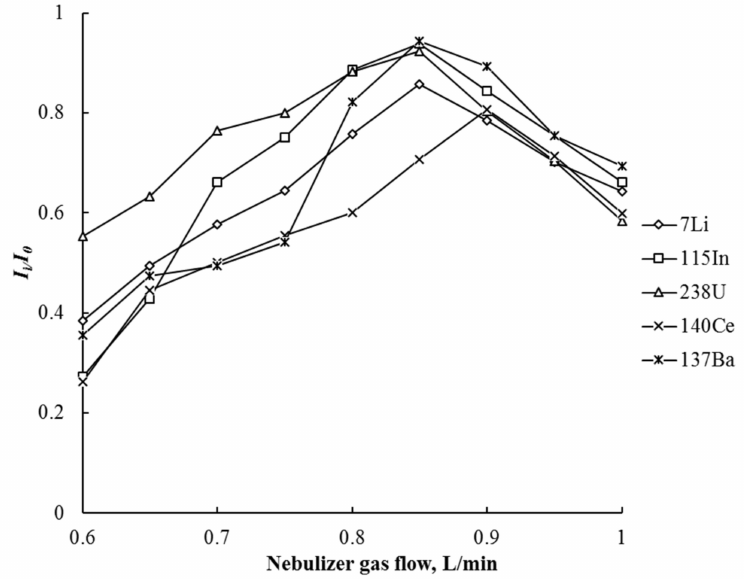
Figure 3. Effect of the nebulizer gas flow on the matrix effect: I 0 —10 µ g/L standard solution; I i —10 µ g/L standard solution with matrix (Sm-Co 500 mg/L: Sm 200 mg/L, Co 300